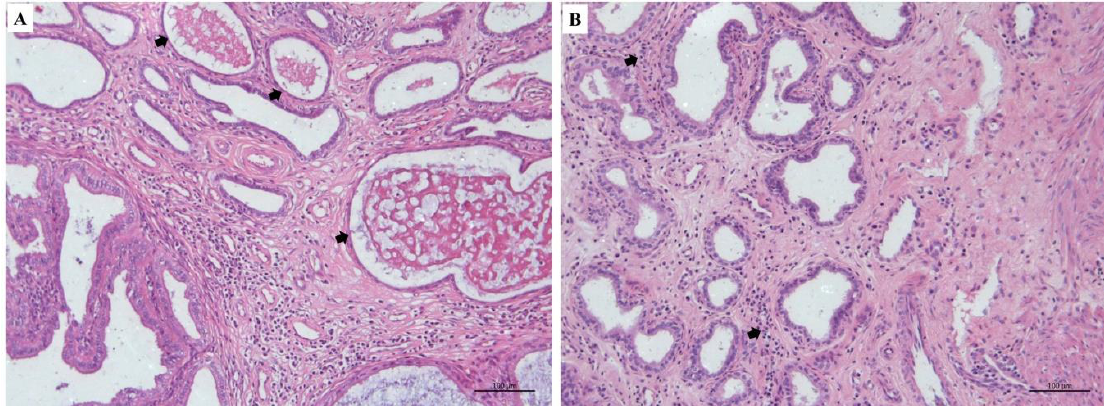
Figure 5. Microscopic uterine findings after pyometra therapeutic protocol. ( A ) endometrial cysts variables in size (arrows) throughout the endometrium; ( B ) stromal content of polymorphonucleated cells (neutrophils) and inflammatory cells infiltrate (arrows). Hematoxylin and eosin stain. Bar scale: 100 μm.